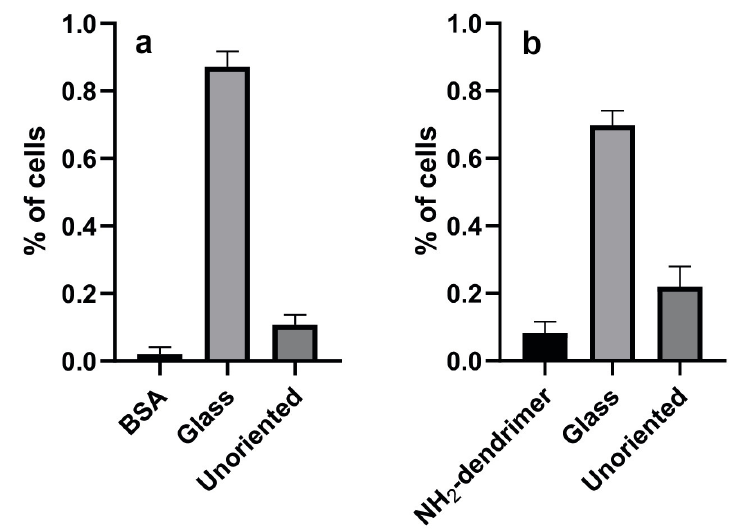
Figure 4. Percentage of separated cells on glass samples with structured molecular landscapes after 24h adhesion time. Cells either oriented along the structures (adhered on molecule layer or glass) or they did not respond to the landscape and remained unoriented. At least 4 independent experiments were performed, all graphs show significance (mean ± sem) between oriented (glass and molecule layer) vs. unoriented cells and molecule layer vs. glass (Student’s t -test, p < 0.05). ( a ) Cell-distribution on BSA µ CP structured glass. ( b ) Cell-distribution on NH 2 -terminated dendrimer µ CP structured